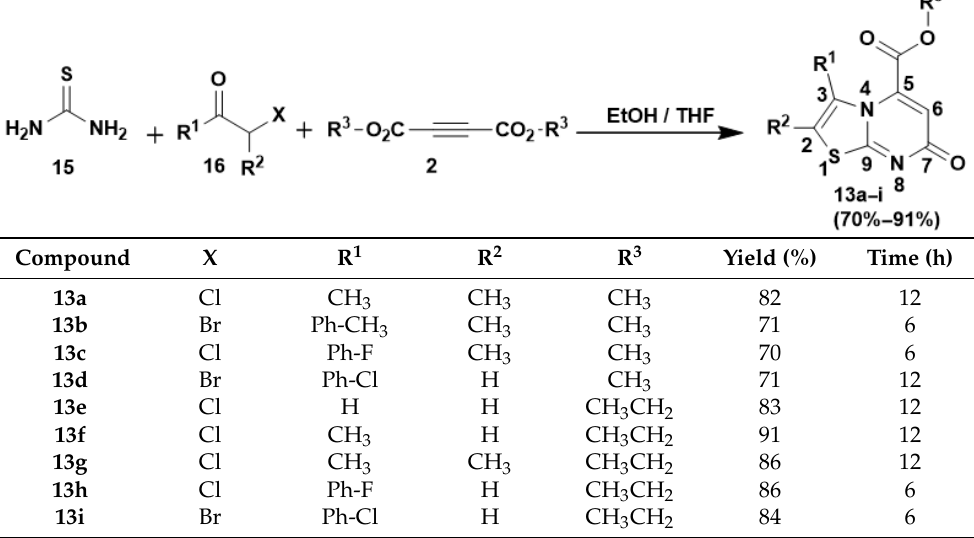
Scheme 4 shows the proposed mechanism for the formation of compound 13 (see Acheson and Wallis [34]). The reaction proceeds by initial nucleophilic attack of the ring- nitrogen of substrate 11 on the α , β -unsaturated ester of DMAD forming an intermediate which undergoes internal cyclisation through nucleophilic attack of the side-chain nitrogen on the ester carbonyl carbon, followed by the loss of methanol, to afford product 13 .